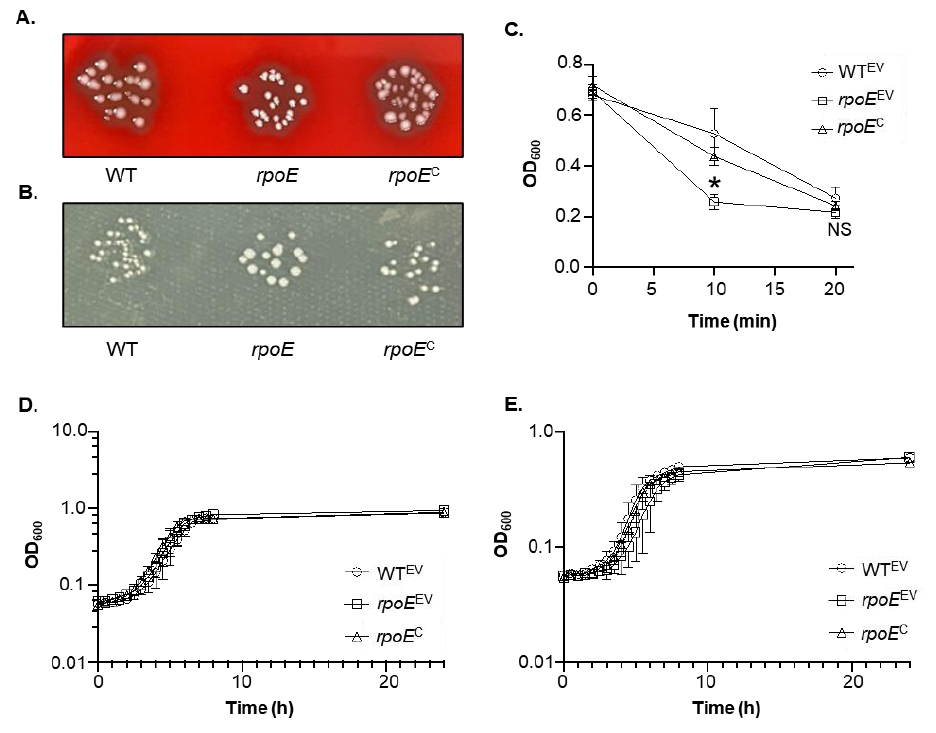
Figure 3. The rpoE mutant alters S. pyogenes colony morphology without impacting growth. ( A , B ) Serial dilutions were performed from overnight cultures of the wild type (WT), rpoE mutant ( rpoE ), or the complemented rpoE mutant strain ( rpoE C ), and dilutions spotted on tryptic soy agar with 5% sheep’s blood ( A ) or Todd Hewitt Yeast agar ( B ) and incubated at 37 °C with 5% CO 2 overnight. ( C ) Cultures were grown to exponential growth and then turbidity was measured over time at an optical density of 600 nm (OD 600 ) after tube inversion to assess aggregation. ( D , E ) Bacteria were grown from a starting OD 600 = 0.05 either in nutrient-rich THY broth ( D ) or nutrient-limiting modified RPMI ( E ) for 24 h and OD 600 was recorded over time. Asterisk indicates statistical significance ( p ≤ 0.05) of the rpoE mutant by comparison to the WT as determined by an unpaired t -test. NS = not significant.